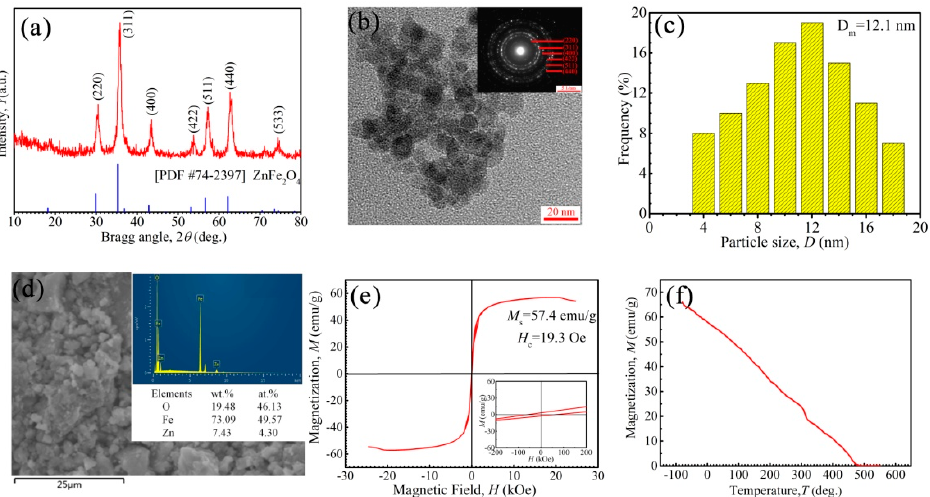
Figure 2. ( a ) XRD pattern, ( b ) TEM image, ( c ) the particle size distribution and ( d ) the SEM and EDS of Zn-ferrite nanoparticle (Zn x Fe 3- x O 4 , the ratio of x is 0.2), ( e ) VSM curve of coated Zn-ferrite EDS of Zn-ferrite nanoparticle (Zn x Fe 3 − x O 4 , the ratio of x is 0.2), ( e ) VSM curve of coated nanoparticles at 25 ° C, and ( f ) the magnetization of Zn-ferrite nanoparticles vs. temperature (3 T).